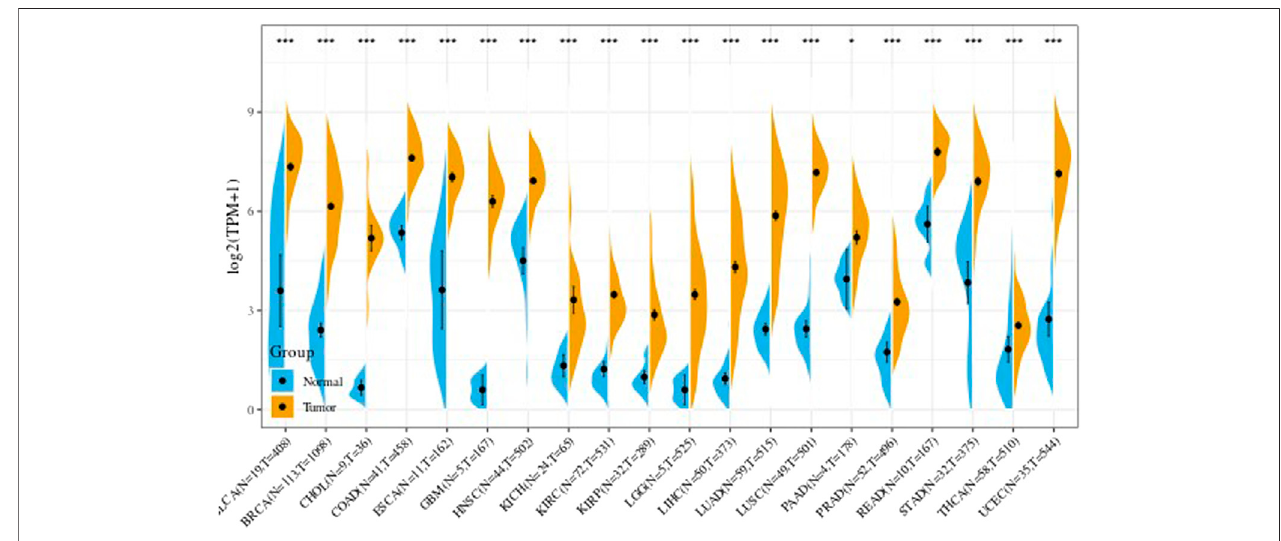
FIGURE 3 | The expression level of UBE2C gene in TCGA tumor and nontumor.